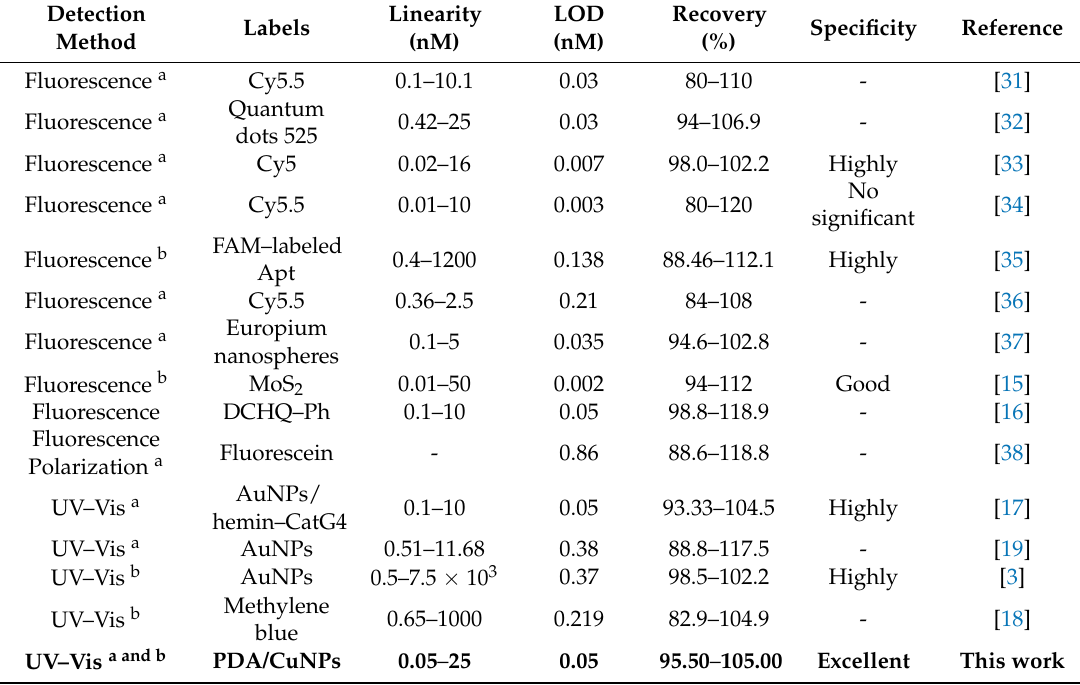
Table 2. Comparison of analytical parameters for MC-LR detection obtained in this study and those reported for previous